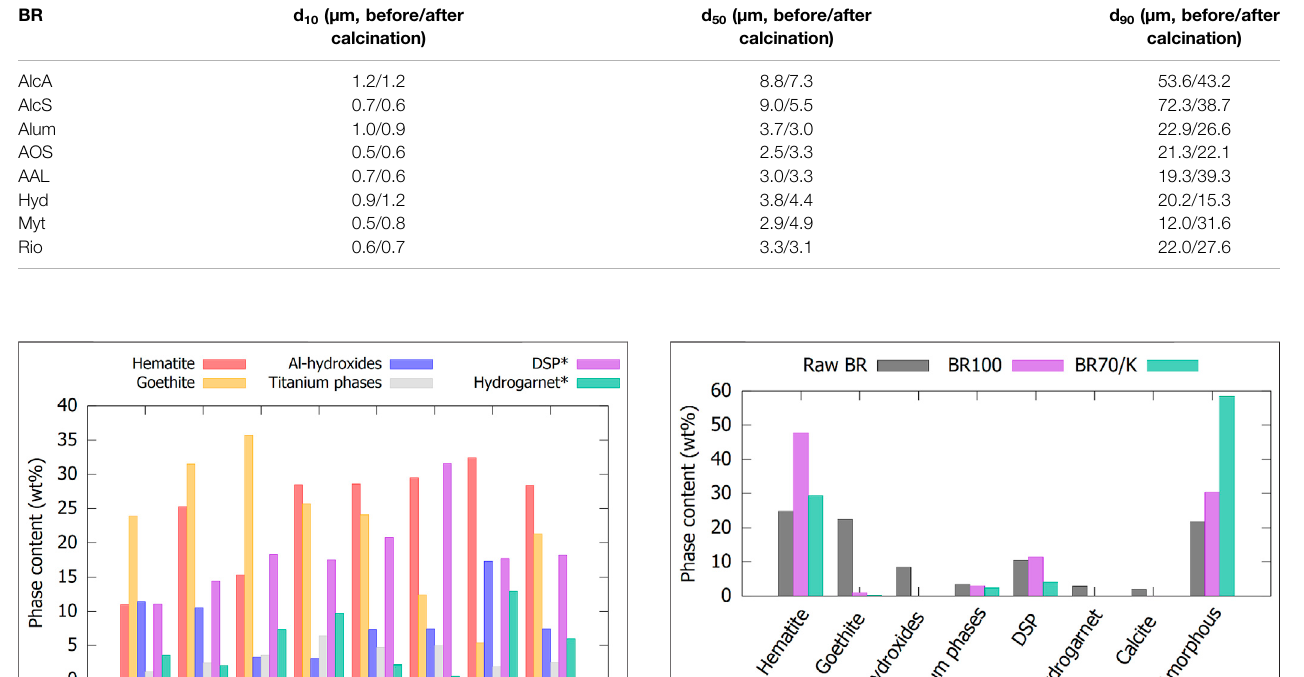
d 90 (µm, before/after calcination)